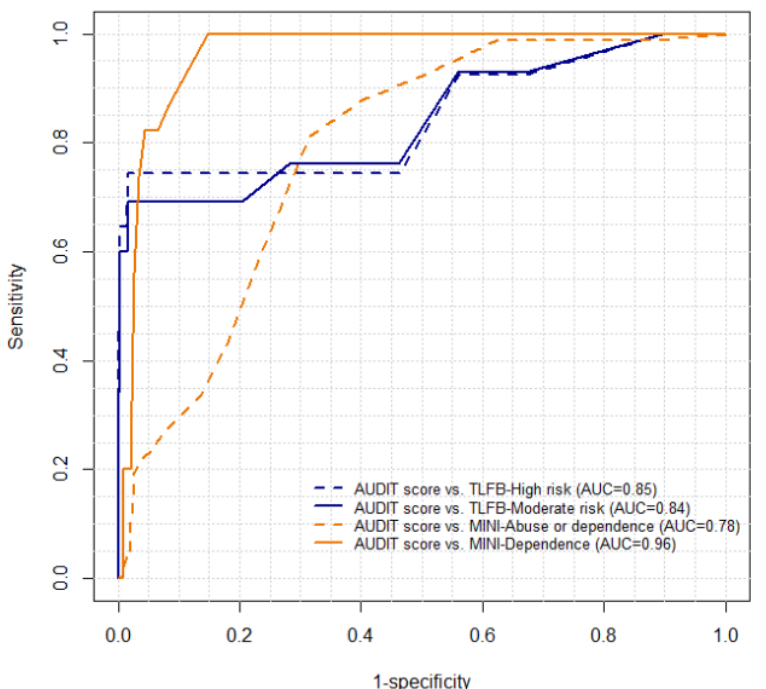
Figure 3. ROC curves and AUC between continuous scores of AUDIT and MINI/TLFB ( n = 287). AUDIT: Alcohol Use Disorders Identification Test; TLFB: Timeline Followback; MINI: Mini Inter- national Neuropsychiatric Interview; ROC: receiver operating curve; AUC: area under the ROC curve.